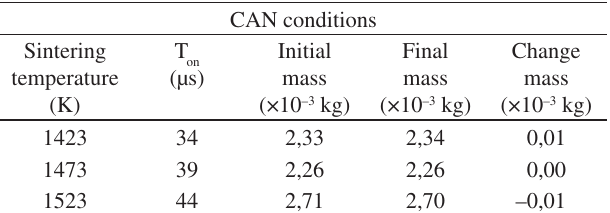
Table 3. Comparison of changes in mass of samples sintered at a pressure of 1333 Pa in CAN setting.